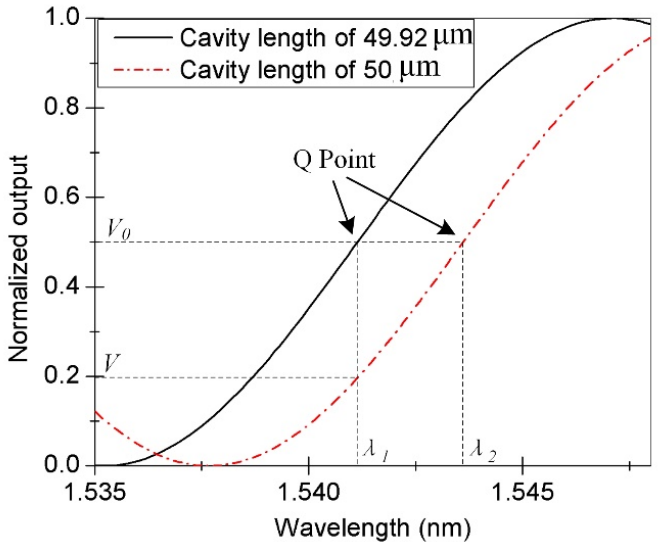
Figure 7. Working-point wavelength corresponding to the Q point under different cavity lengths.